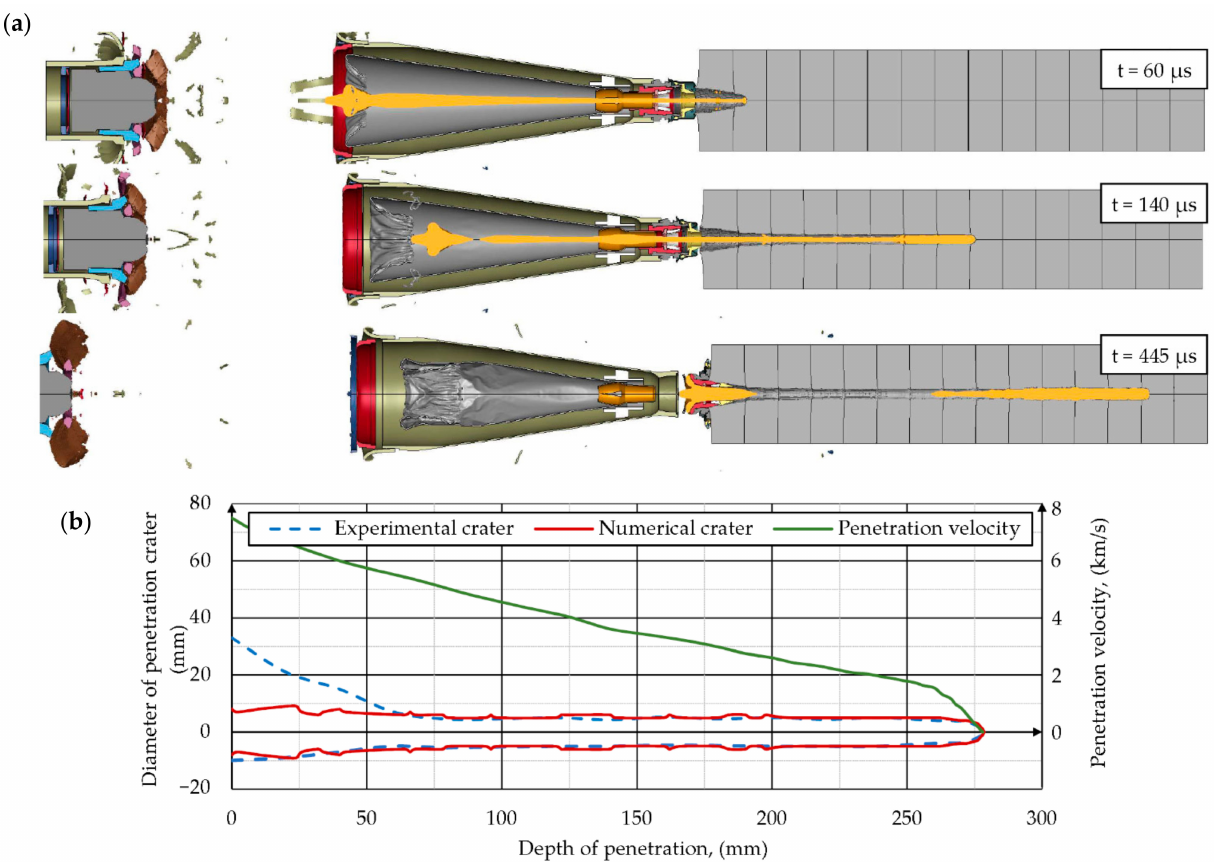
Figure 15. Results of simulations: ( a ) deformations of components at different times after the detonation of the PG-7M warhead; ( b ) penetration crater